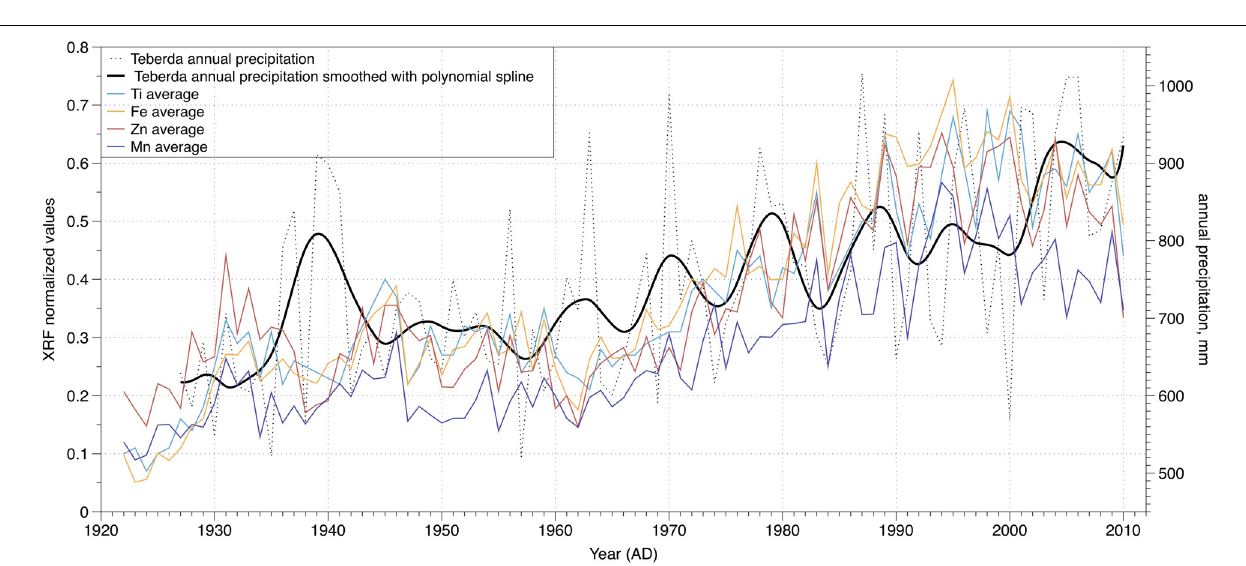
FIGURE 9 | Annual precipitation recorded at the Teberda meteorological station compared with the yearly averaged values of terrigenous elements.